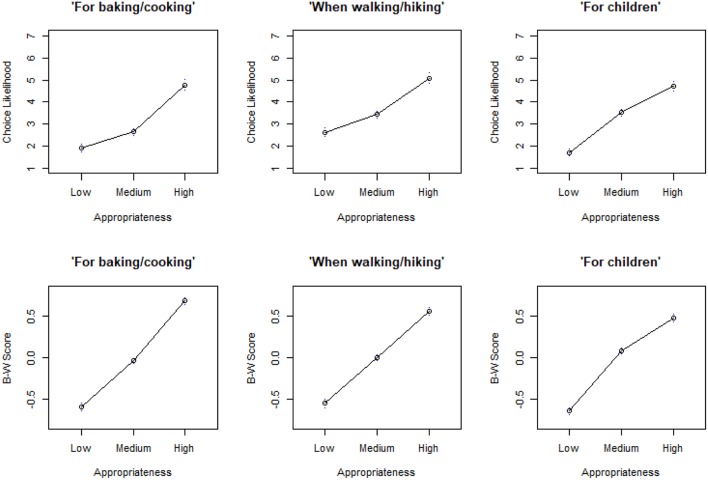
Mean choice likelihood ratings and B–W scores by level of appropriateness for Studies 9a (top) and 9b (bottom).